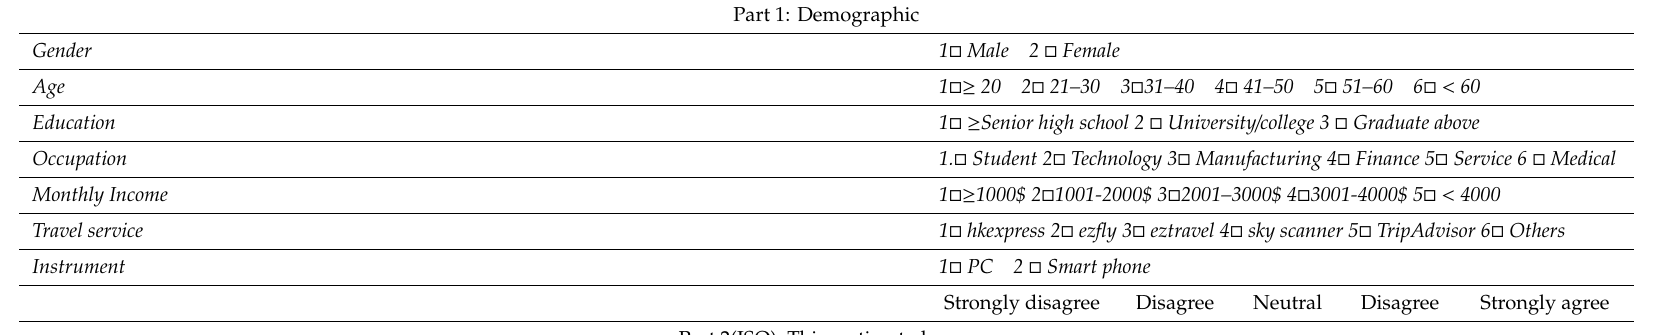
Table A1. Survey